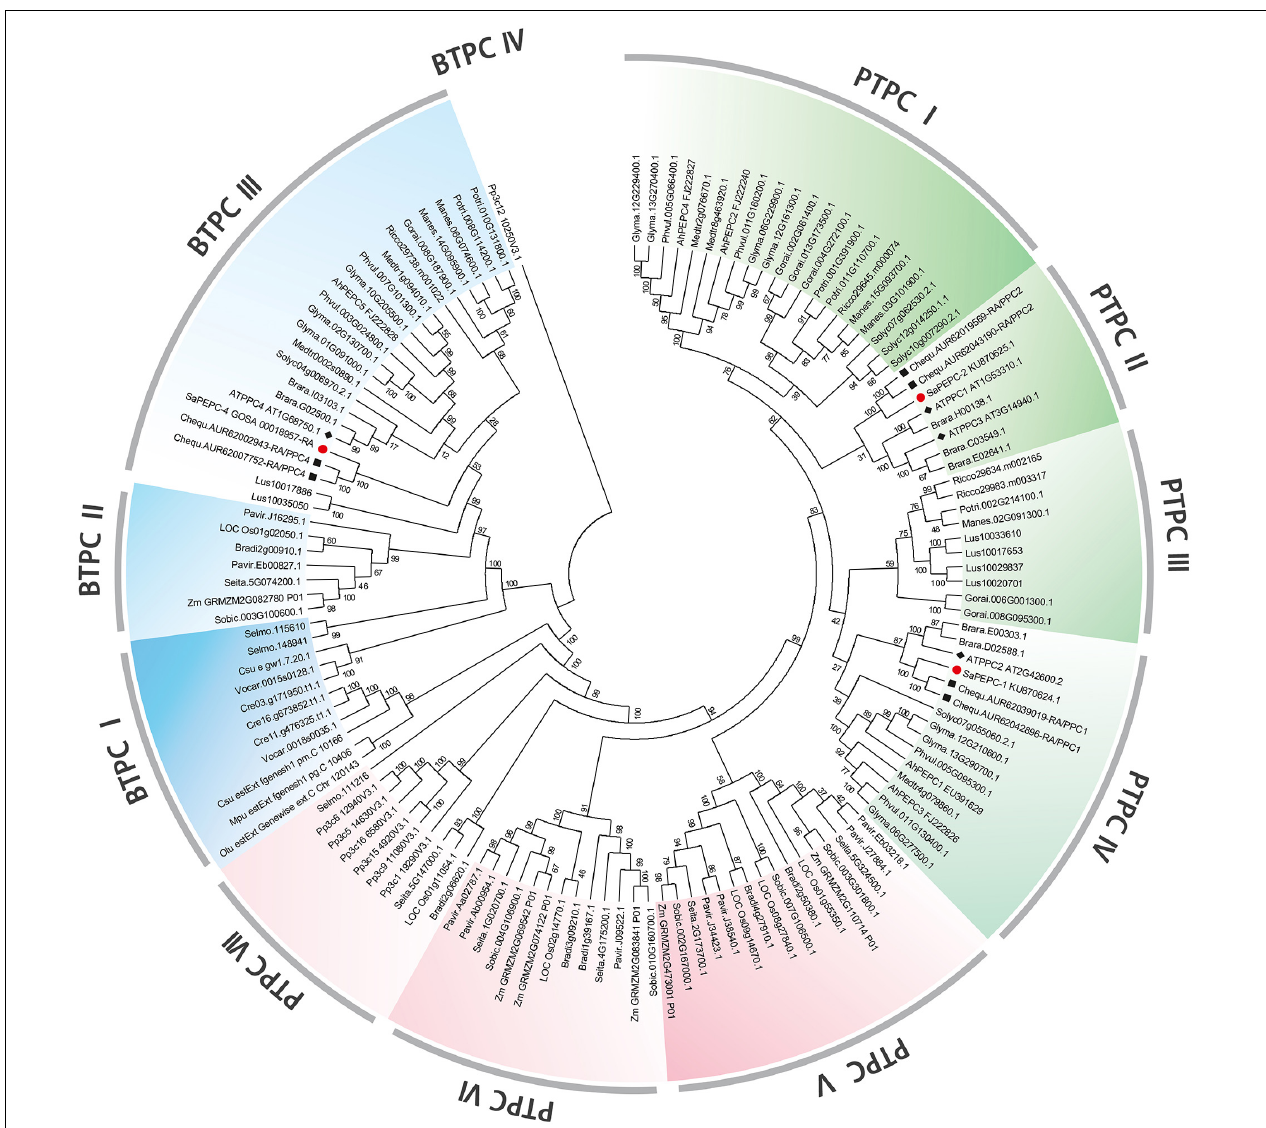
FIGURE 1 | Phylogenetic tree of phosphoenolpyruvate carboxylase ( PEPC ) gene family in different plant species. Green (dicots) and red (monocots, mosses, and ferns) portions are the plant types of PEPC (PTPC); the blue part is a bacterial type of PEPC (BTPC). At, Arabidopsis thaliana ; Ah, Arachis hypogaea ; Bradi, Brachypodium distachyon ; Brara, Brassica rapa ; Chequ, Chenopodium quinoa ; Cre, Chlamydomonas reinhardtii ; Csu, Coccomyxa subellipsoidea ; Glyma, Glycine max ; Gorai, Gossypium raimondii ; Lus, Linum usitatissimum ; Manes, Manihot esculenta ; Mt, Medicago truncatula ; Mpu, Micromonas pusilla ; LOC Os, Oryza sativa ; Olu, Ostreococcus lucimarinus ; Pavir, Panicum virgatum ; Phvul, Phaseolus vulgaris ; Pp3c, Physcomitrella patens ; Potri, Populus trichocarpa ; Rc, Ricinus communis ; Selmo, Selaginella moellendorffii ; Seita, Setaria italica ; Solyc, Solanum lycopersicum ; Sobic, Sorghum bicolor ; Sa, Suaeda aralocaspica ; Vocar, Volvox carteri ; and Zm, Zea mays . The symbols of red circle, black box, and black diamond box indicate the PEPC gene family members in S. aralocaspica , C. quinoa , and Arabidopsis ,